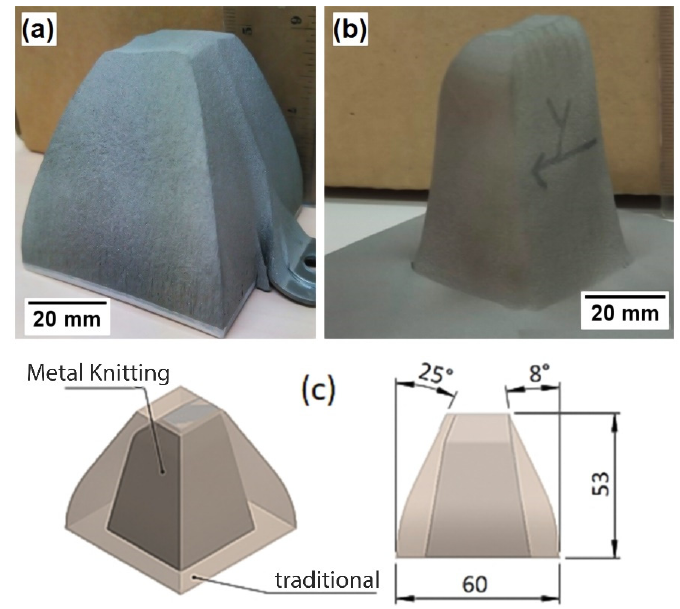
Figure 9. CSAM 316L bulks. ( a ) traditional strategy on the substrate edges and ( b ) Metal Knitting strategy on flat substrate. ( c ) scheme comparing the geometries obtained.